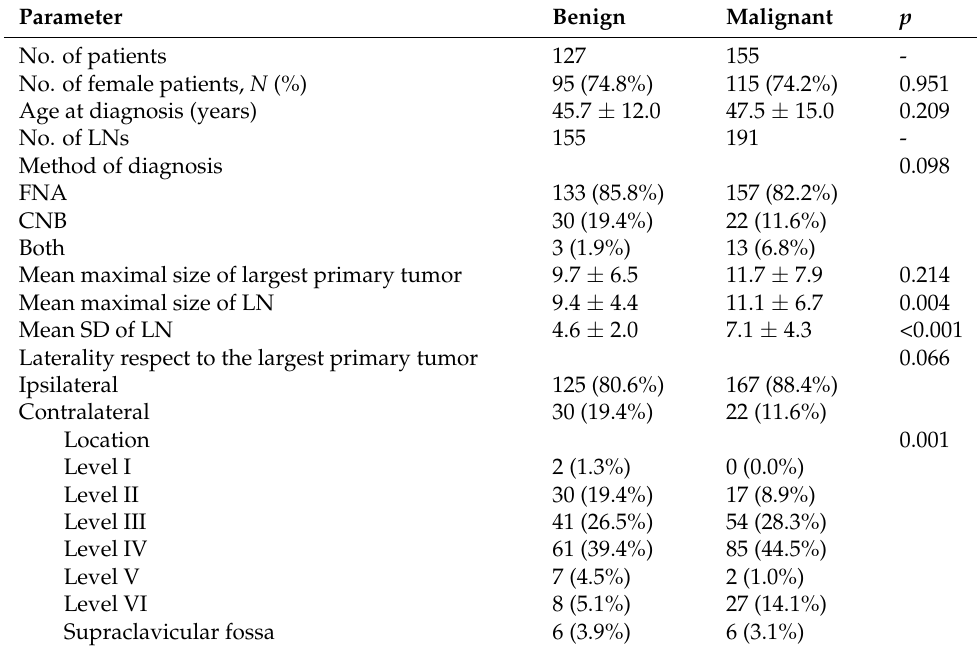
Table 1. Demographic and clinical characteristics of patients and lymph nodes (LN).